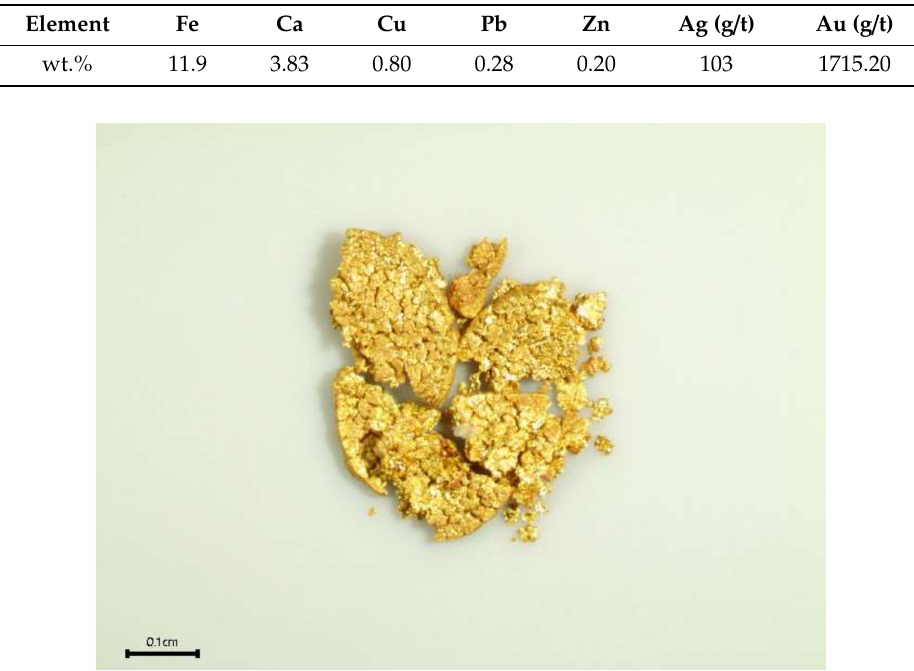
Figure 1. Stereoscopic microscope image of a gold particle from raw concentrate by lead-fire assay.